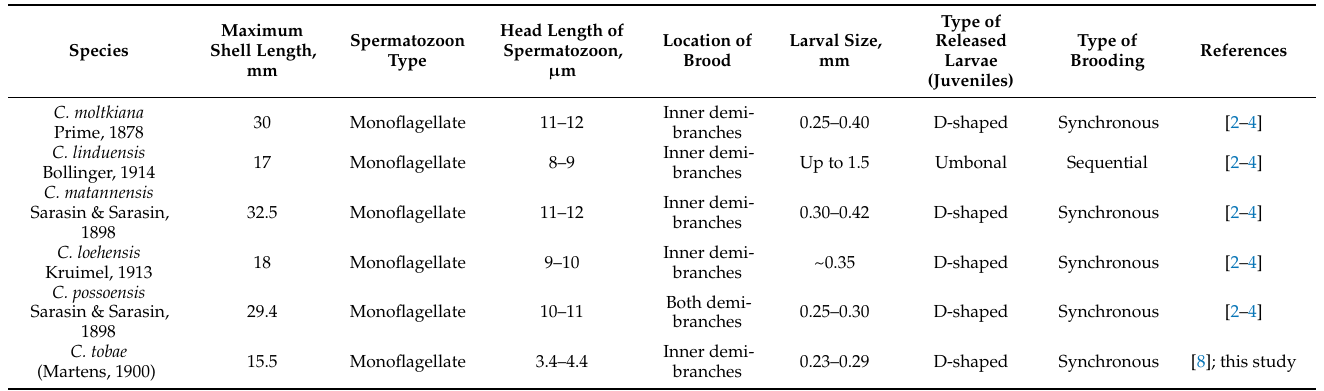
Table 1. Reproductive features of brooding Corbicula species from Indonesian